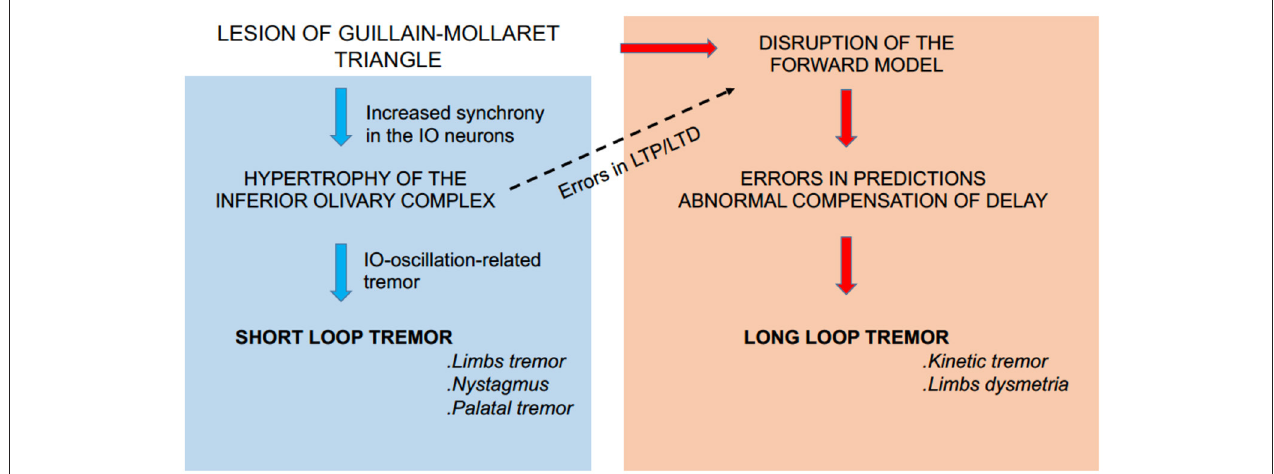
FIGURE 4 | Summary diagram. A lesion in the G–M triangle may well-disrupt the short loop (left panel) and the long loop (right panel) to cause the diverse types of tremors. In addition, the aberrant activities in the short loop (i.e., aberrant complex spike activities) may induce secondary maladaptation of cerebellar forward models through aberrant patterns of LTD and/or LTP of the cerebellar circuitry (dashed